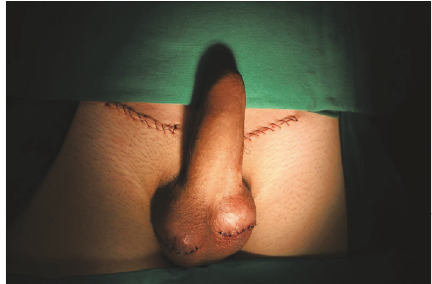
Figure 4: Patient after surgical correction.